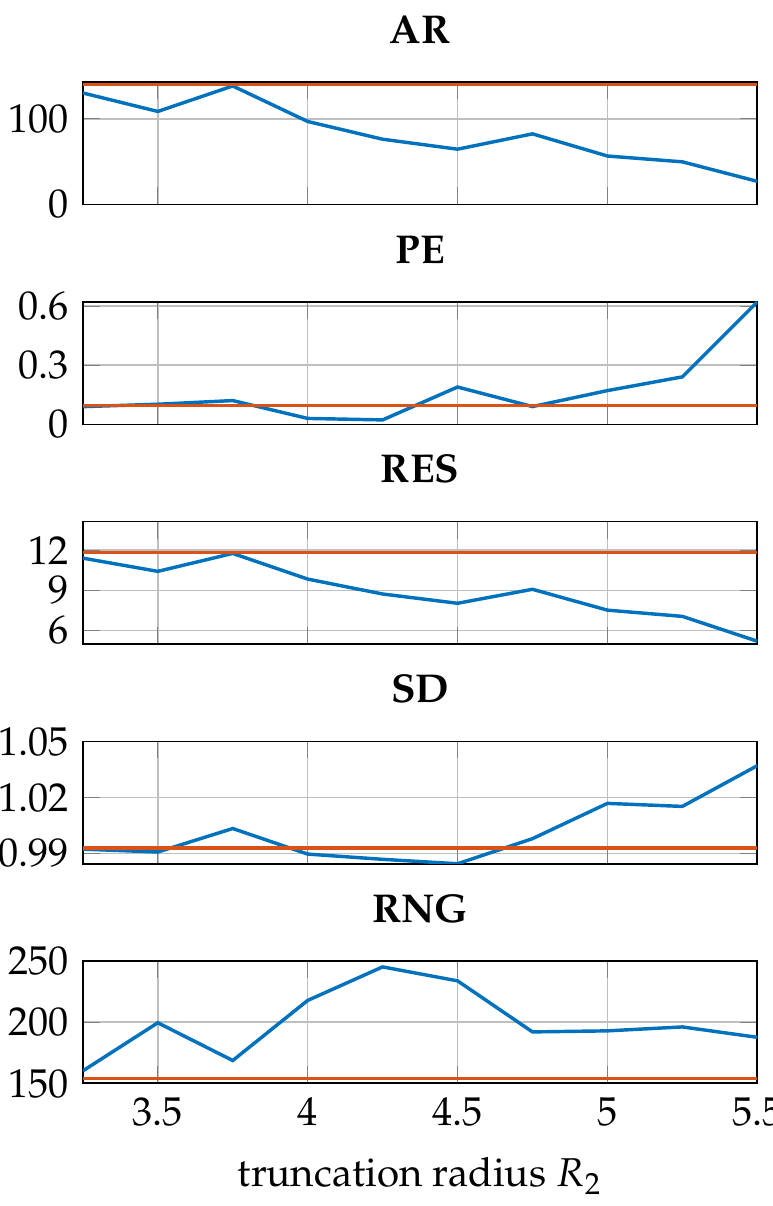
Figure 13. GREIT figures of merit for the combination of EIT and radar data, for R 1 = 3 with 0.75% noise. The orange line represents the scores of the EIT-only data. R 2 was increased from 3.25 to 5.5 in steps of 0.25.